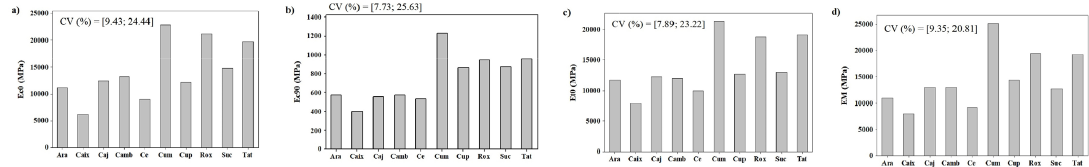
, E , E and E for wood species. (a) longitudinal modulus of elasticity in compression parallel to the fiber Figure 4. Mean values of E c0 c90 t0 M (E ), (b) normal to the fibers (E ), (c) in tension parallel to the fiber (E ), (d) conventional modulus of elasticity in the static bending test c0 c90 t0 (E ) as a function for wood species (Ara – Cedroarana; Cax – Caixeta; Caj – Cajueiro; Camb – Cambará; Ce – Cedro; Cum – Cumaru; M Cup – Cupiúba; Rox – Roxinho; Suc – Sucupira; Tat – Tatajuba), respectively. Inserted in these Figure 4a-d upper side the lower and higher values of the coefficient of variation (CV) obtained.